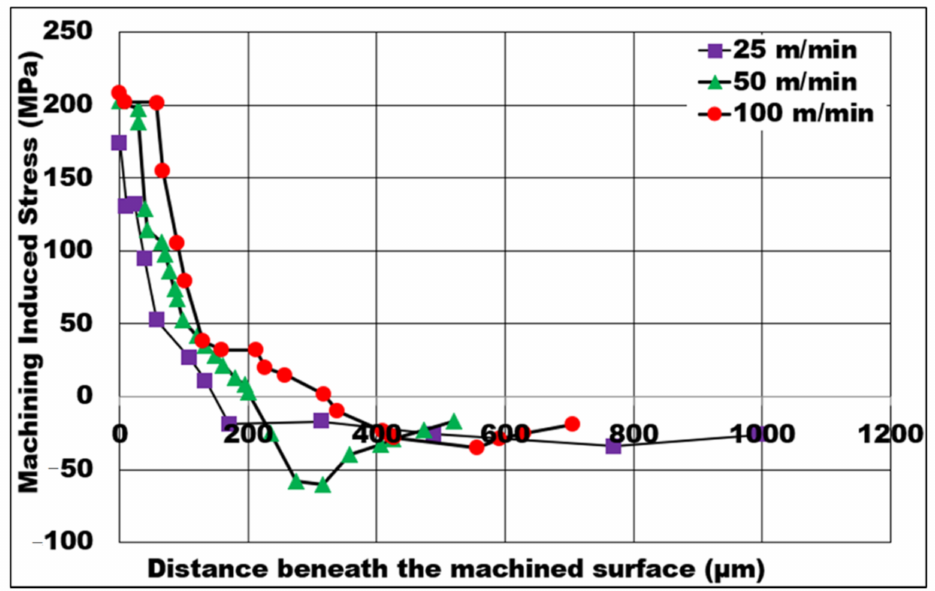
Figure 8. FE simulation of the effect of the cutting speed on machining-induced stress when cutting 10% volume fraction syntactic foam (uncut chip thickness = 0.07 mm).